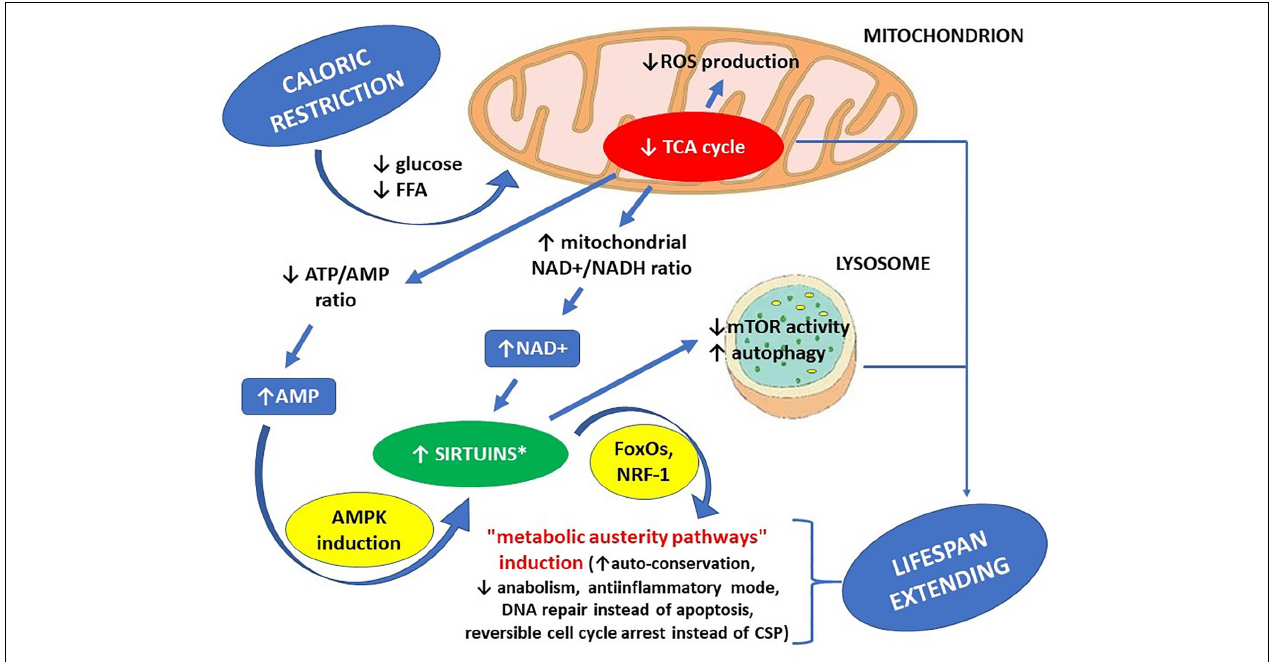
FIGURE 1 | Life span-extending effects of caloric restriction – the key role of sirtuins. ∗ increased availability of NAD+ can activate all sirtuins, while increased AMP concentration can activate all sirtuins except SIRT4. AMP – adenosine monophosphate, AMPK – AMP-activated protein kinase, ATP – adenosine triphosphate, CSP – cell senescence phenotype, FFA – free fatty acids, FoxOs – forkhead box proteins, mTOR – mammalian target of rapamycin kinase (a protein), NAD+ – nicotinamide adenine dinucleotide, NADH – nicotinamide adenine dinucleotide hydride (reduced NAD+), NRF-1 – nuclear respiratory factor 1 (a transcription factor), ROS – reactive oxygen species, TCA cycle – tricarboxylic acid